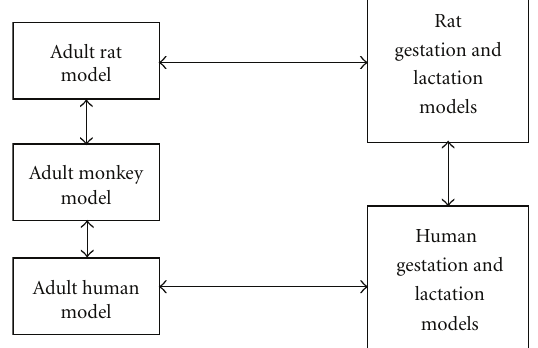
Figure 2: Parallelogram approach for developing Mn PBPK models for adult humans, as well as gestation and